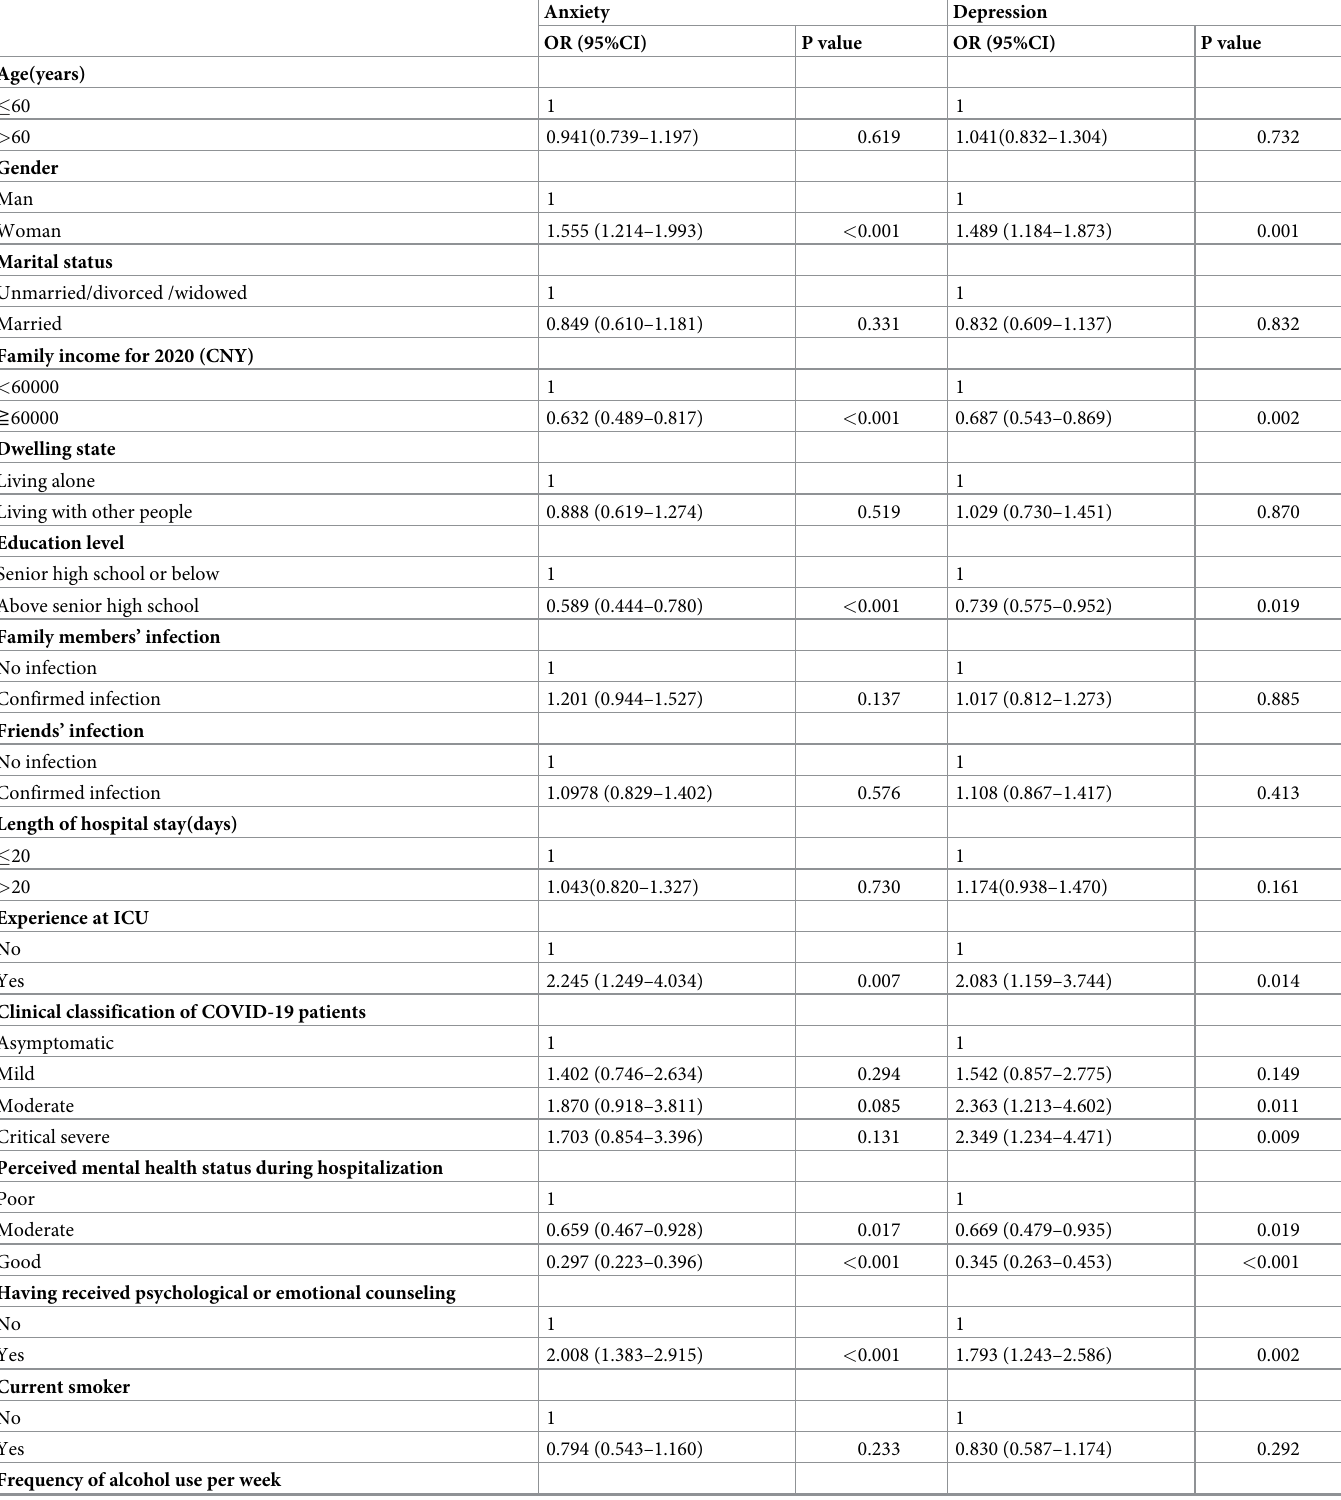
Table 4. Univariate statistical analysis of adverse psychological outcomes in enrolled COVID-19